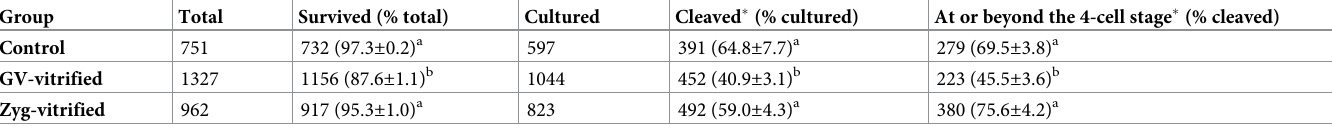
Sixteen replications were performed. Percentage data are shown as mean ± SEM. Different superscripts in the same column (a,b) denote significant differences (P < 0.05). � Recorded on Day 2 (IVF = Day